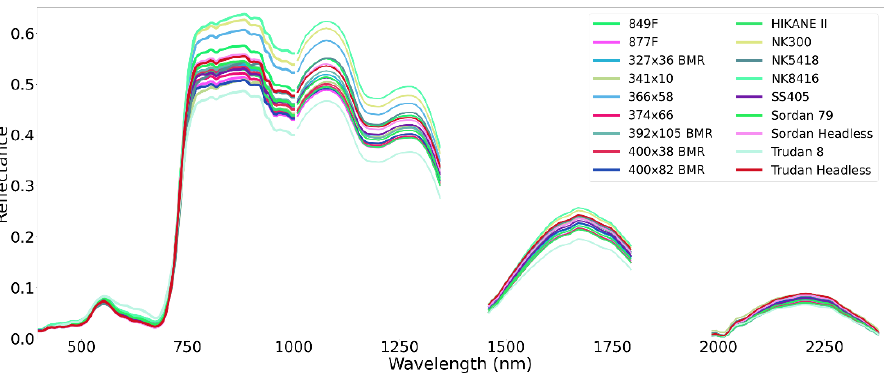
Figure 5. Spectra of the 18 Sorghum Varieties in HyCal-18 panel on 18 July 2018. The varieties are very similar in the visible range of the spectrum, but substantial variability is observed in the near infrared (NIR) portion of spectrum.